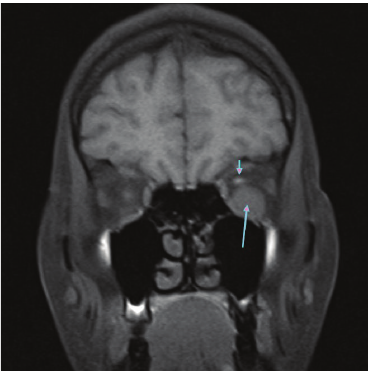
Figure 1: Axial noncontrast CT image showing a hyperdense retrobulbar mass in left orbit (arrow).